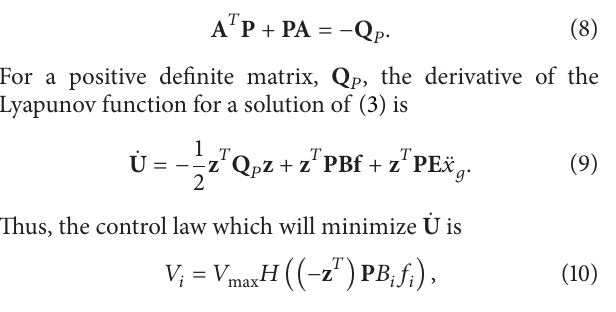
𝑚 , 𝑚 ,... , and 1 2 ̈𝑥 𝑔 indicates one-dimensional